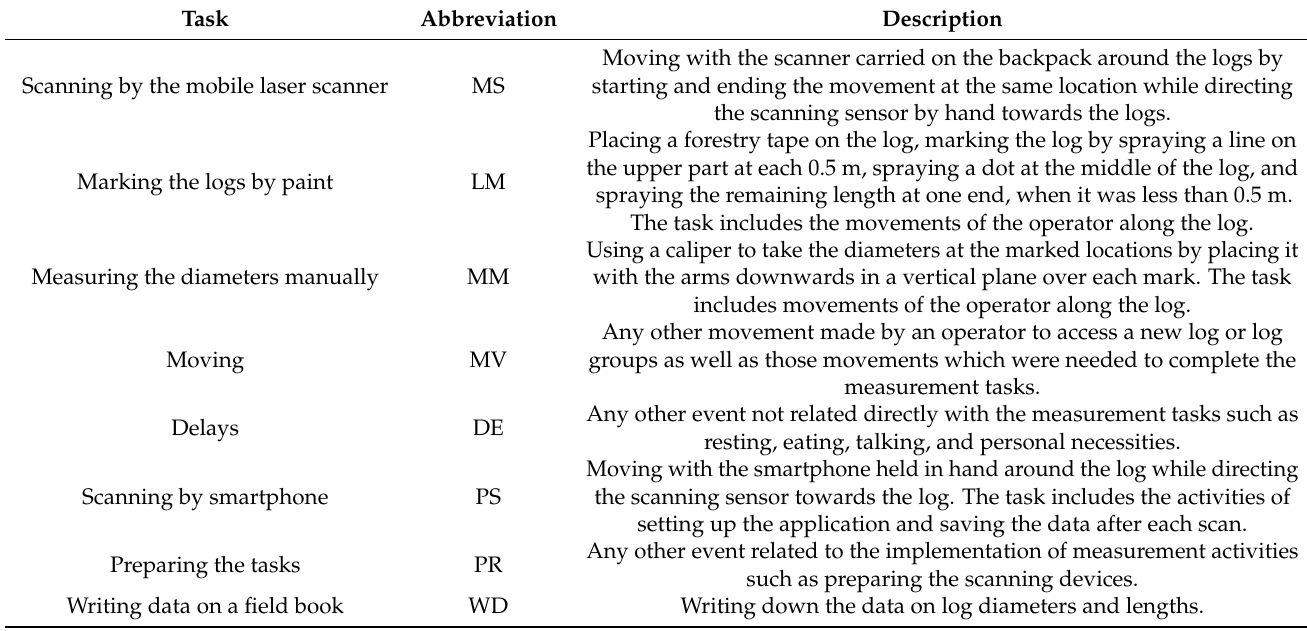
Table 1. Description of the main observed tasks following the OWAS analysis.